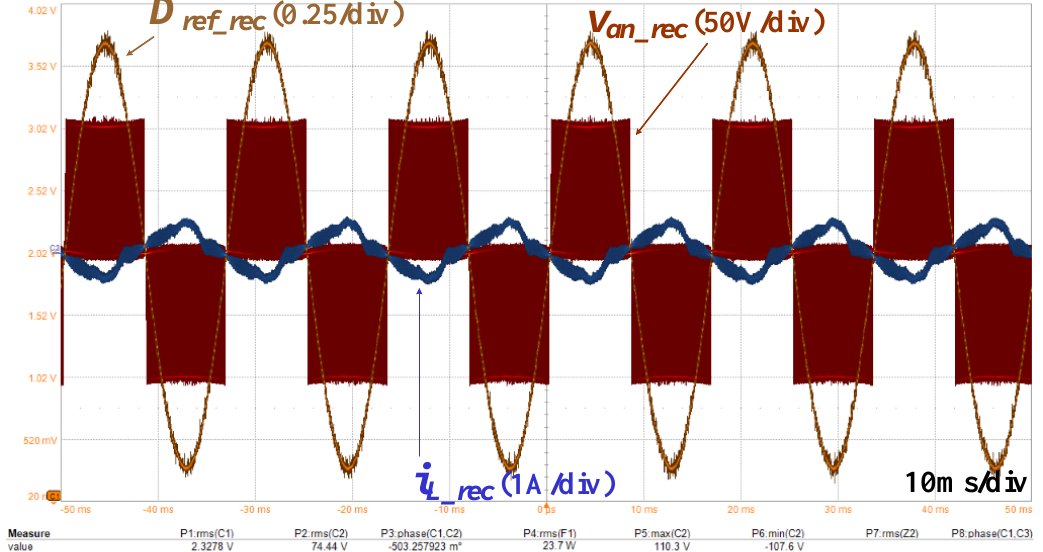
Figure 13. The input voltage, current and duty reference of the rectifier.